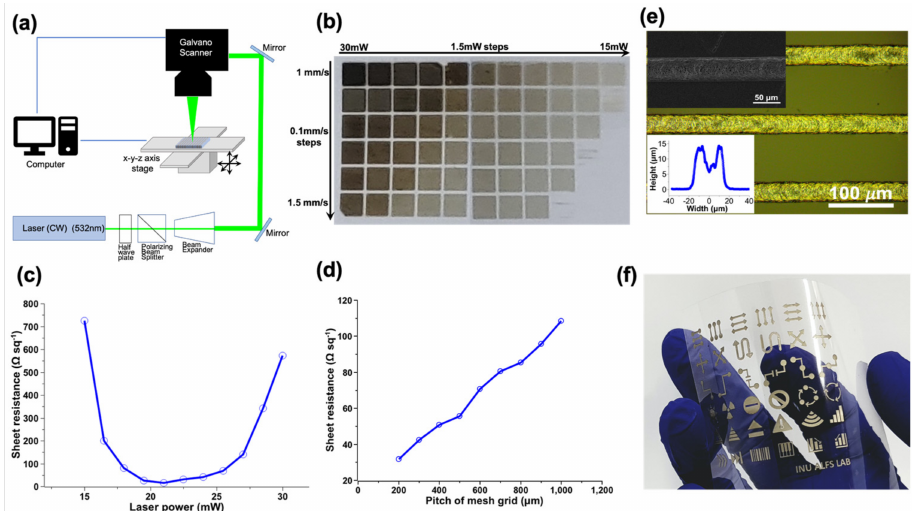
Figure 1. Laser-based fabrication. ( a ) Schematic of laser system for sintering; ( b ) image of patterning for parametric study, according to scanning speed and laser power; ( c ) change in sheet resistance by changing the laser power at a constant scanning speed of 1.2 mm/s; ( d ) change in sheet resistance with different pitch of the grid pattern with 22.5 mW of laser power and 1.2 mm/s of scanning speed; ( e ) image of the sintered pattern on PET (inset: (top): SEM image and inset (bottom): cross-sectional profile of a sintered pattern), and ( f ) the diverse shape pattern on the PET